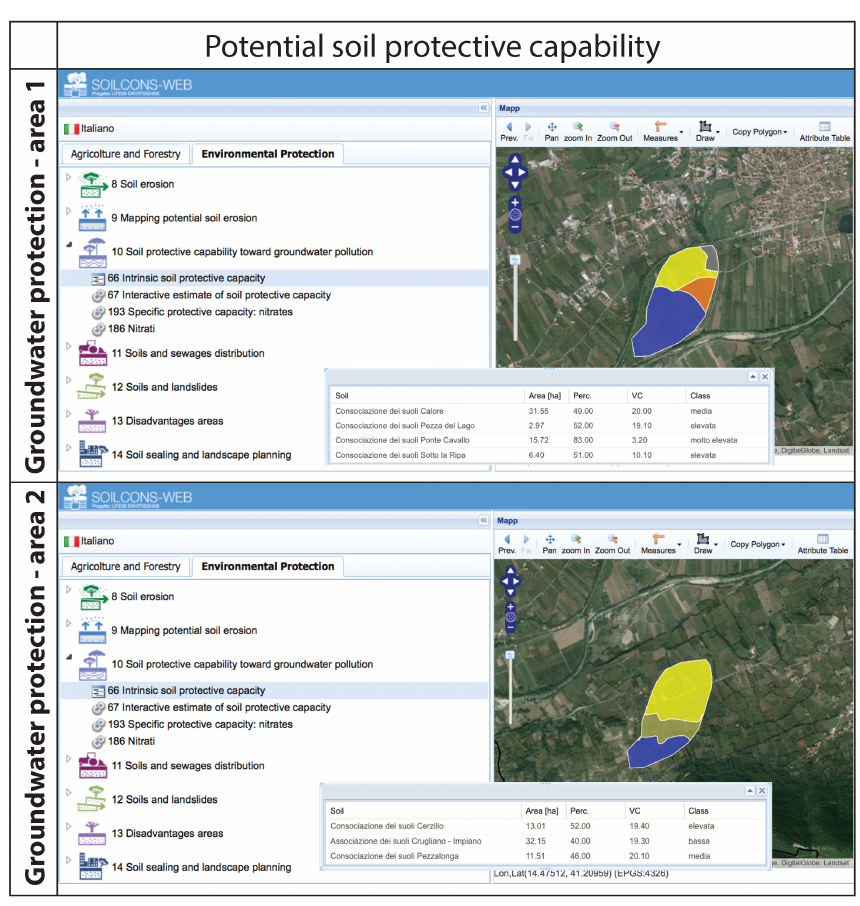
Figure 8. Output examples from the “Soil protective capability towards groundwater pollution” tool: intrinsic soil protective